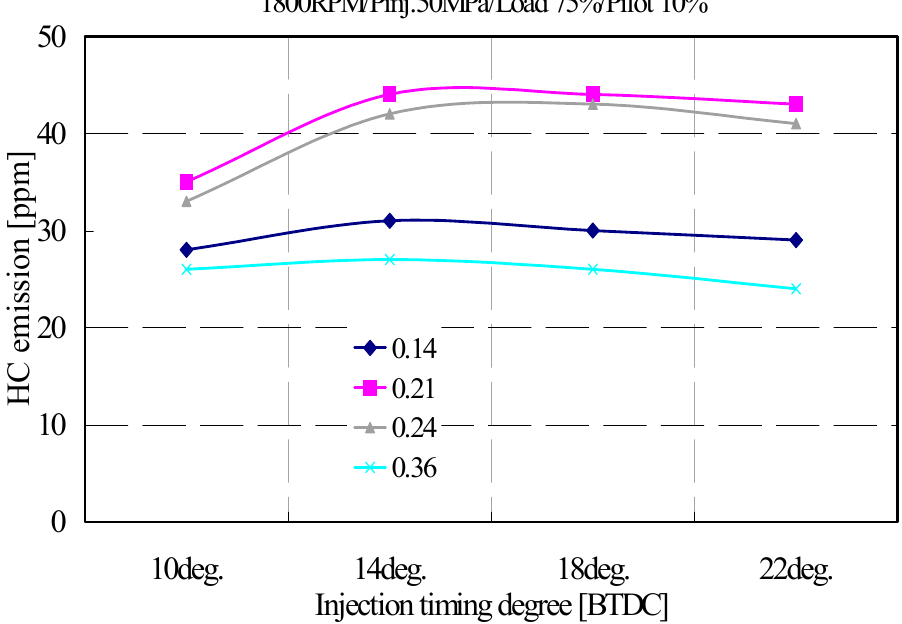
Figure 16. HC emission characteristic of DME engines with nozzle needle lift as a function of injection timing degree.